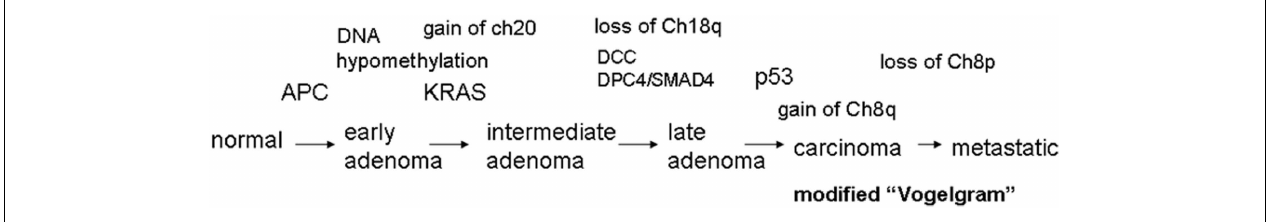
order, was emphasized. DNA hypermethylation also was mapped in the early adenoma stage. Later, gain of Chromosome 20 (Davison et al., 2005; Wang et al., 2013), gain of chromosome 8q and loss of Chromosome 8p (Bacolod and Barany, 2010), and mutation in DPC4/SMAD4 (Fleming et al., 2013) were